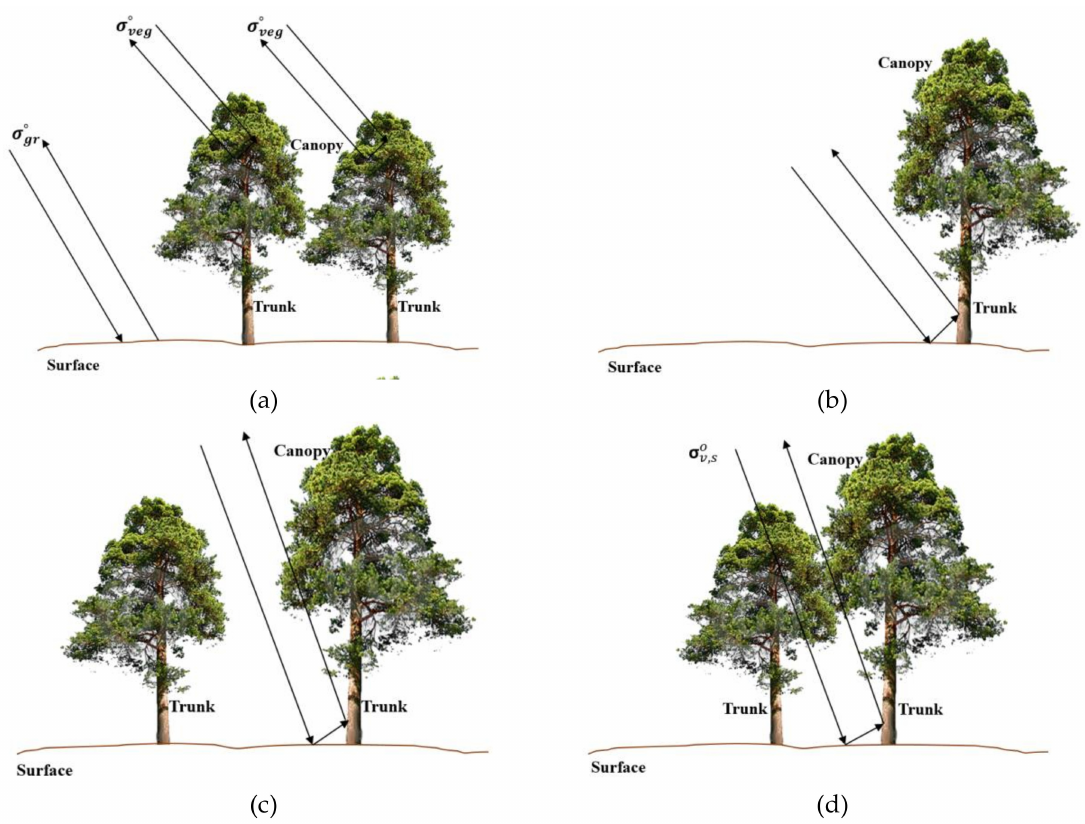
Figure 9. Interaction of electromagnetic waves with forest vegetation: ( a ) water cloud model, ( b ) ground–stem interaction from canopy gaps, ( c ) ground–stem interaction through the canopy, ( d ) canopy volume scattering to the ground and further scattering through the